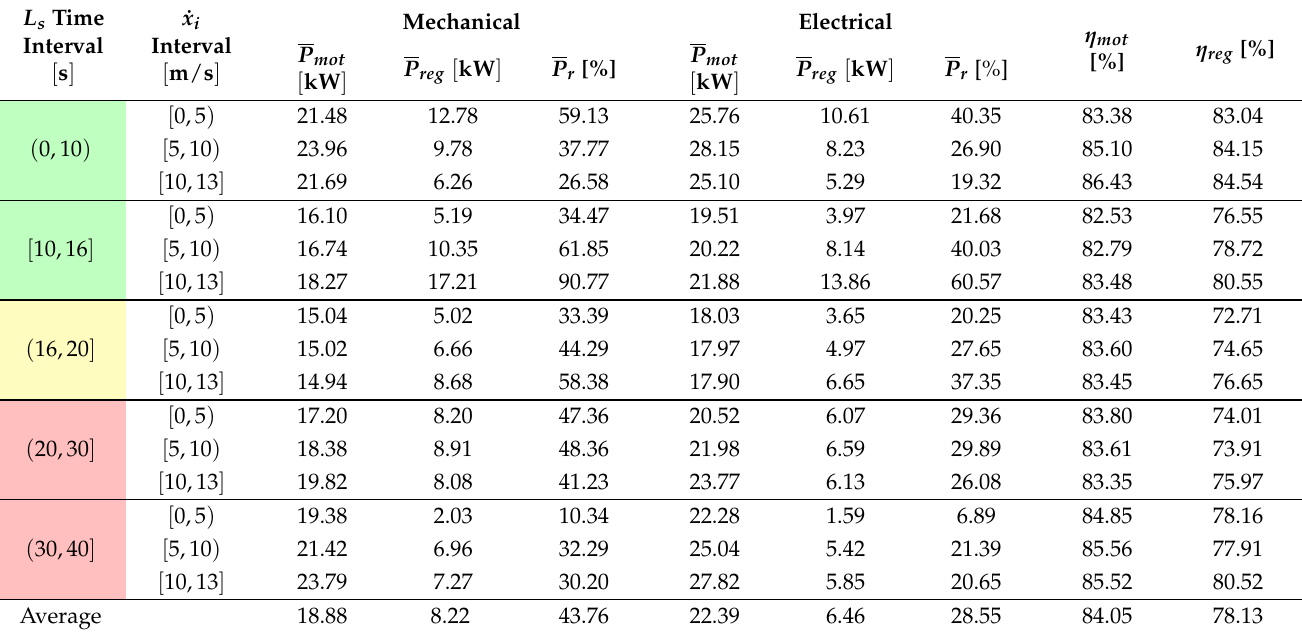
Table 6. Fuzzy logic-based controller power